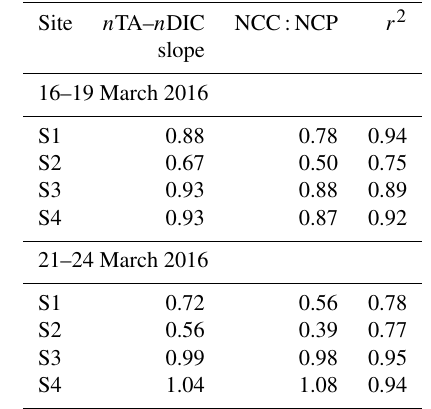
Table 1. Slope of salinity normalized total alkalinity ( n TA) to salinity normalized dissolved inorganic carbon (DIC), net community calcification to net community production ratio (NCC:NCP = 2 (cid:49) DIC / ( (cid:49) TA-1)) (Suzuki and Kawahata, 2003), and correlation coefficients ( r 2 )